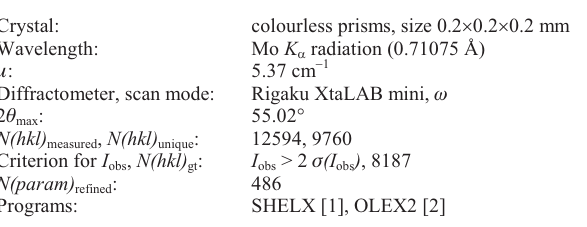
Table 1. Data collection and handling.